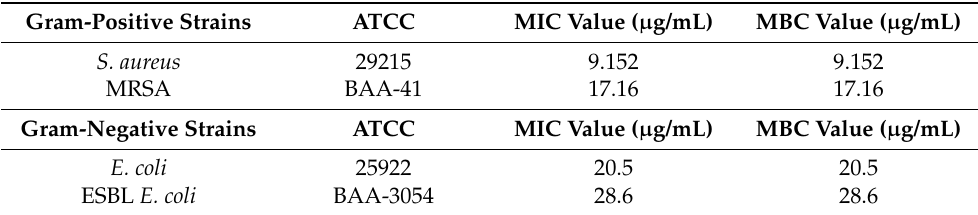
Table 1. MIC and MBC values of alapropoginine against the four bacterial strains employed in the